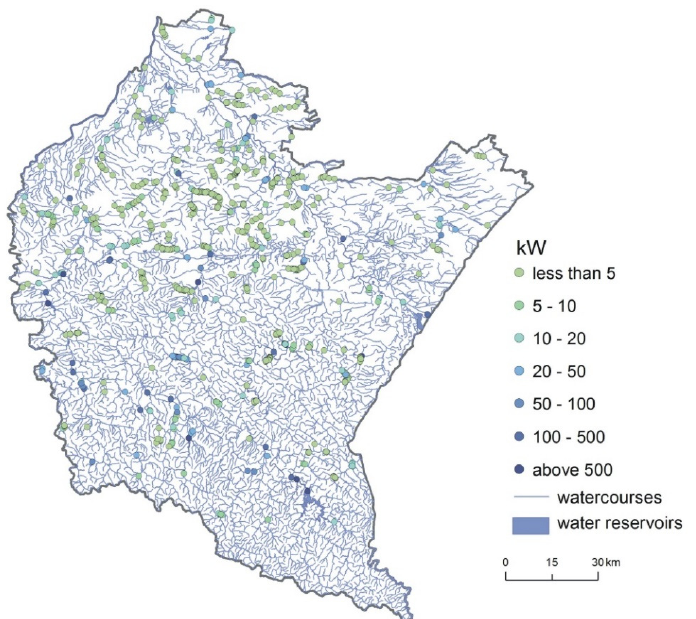
Figure 14. Localization of water dams and power of the potential hydropower plants in the Pod- karpackie voivodeship (own elaboration).